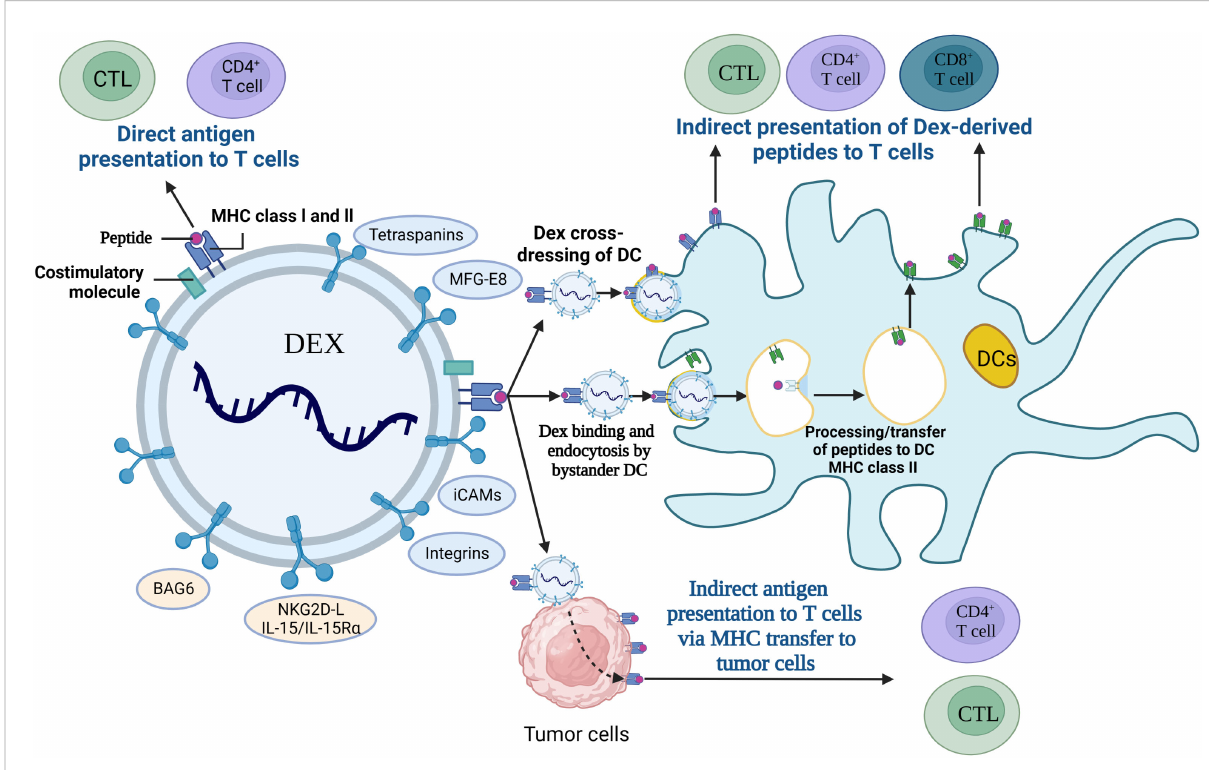
FIGURE 6 Interaction of DEXs with immune cells. CTL; cytotoxic T lymphocyte, DCs; Dendritic cells, MFG-E8; milk fat globule EGF factor 8, iCAMs; intercellular cell adhesion molecules, BAG6; Bcl-2-associated athanogen-6, NKG2D-L; natural killer group 2, member D receptor ligands, Dex; DC-derived exosomes, MHC; major histocompatibility